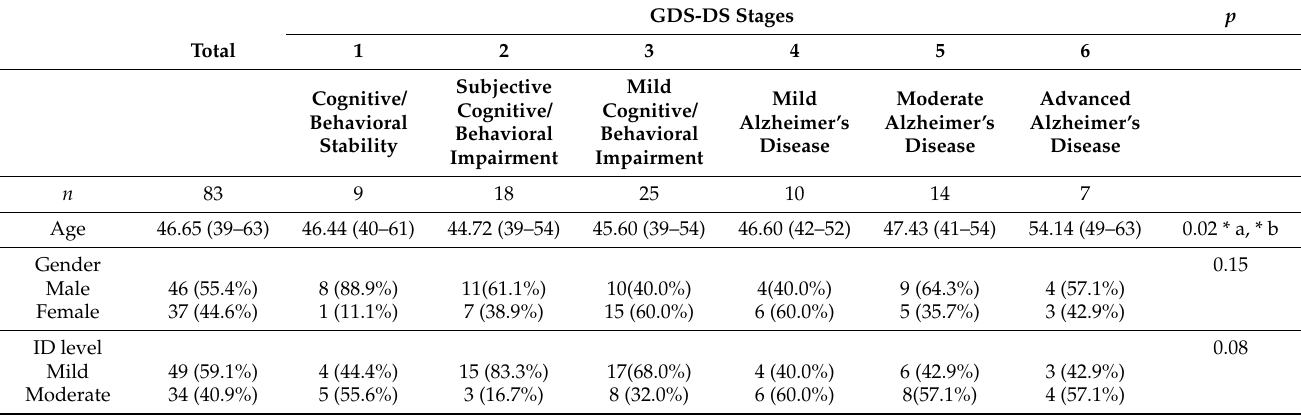
Table 5. Demographics for each stage of the global deterioration scale for people with Down’s syndrome.